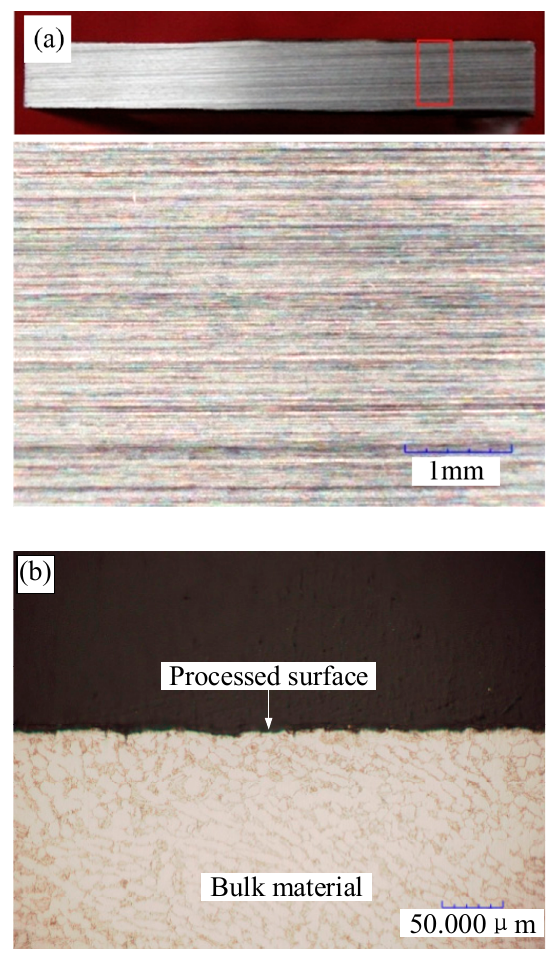
Figure 14. Workpiece surface ( a ) photograph; ( b ) microstructure beneath the ground surface.